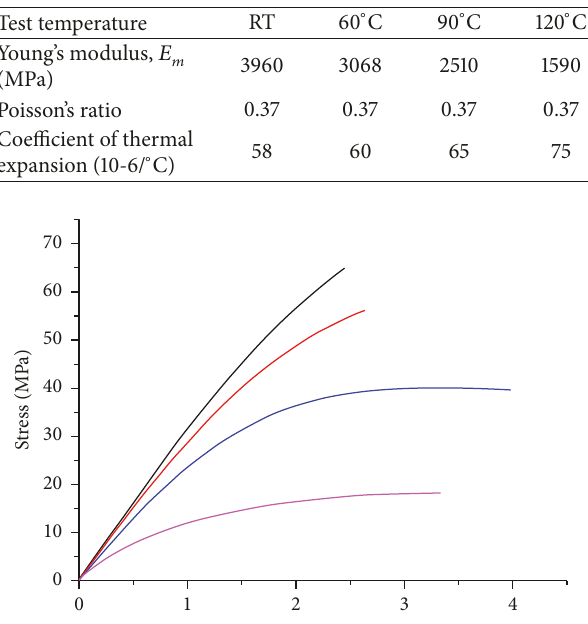
Table 1: Matrix properties at room temperature used for the numerical simulations.